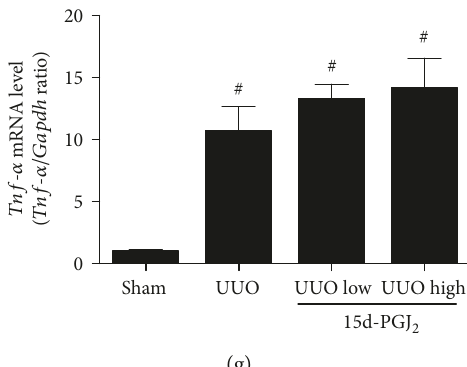
Figure 2: 15d-PGJ enhances the proin fl ammatory response during 3-day UUO (3dUUO). (a) Nuclear protein extracts were used to analyze 2 cortical NF- κ B P65 subunit nuclear protein expression (Nuc). (b) Cortical cytoplasmic protein expression (Cyt) of the NF- κ B P65 subunit. (c) Cortical cytoplasmic protein expression of I κ B α . (d) F4/80 mRNA levels in the kidney cortex. (e) Ly6G mRNA levels in the cortex. (f) Mcp-1 mRNA levels in the cortex. (g) Tnf- α mRNA levels in the cortex. Representative blots are shown above each graph. 15d-PGJ administered at a low (0.5 mg/kg/day) and a high (1 mg/kg/day) dose as depicted in each graph. Data represents mean ± SEM. # P < 0 05 versus that in sham; ∗ P < 0 05 versus that in UUO, using ANOVA and Bonferroni ’ s post hoc tests ( n = 5 , sham; n = 6 , UUO groups). UUO, unilateral ureteral obstruction.